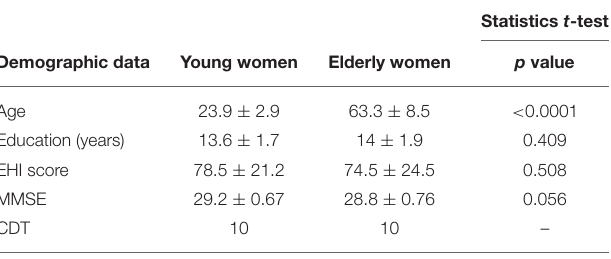
TABLE 1 | Demographic and clinical data for both